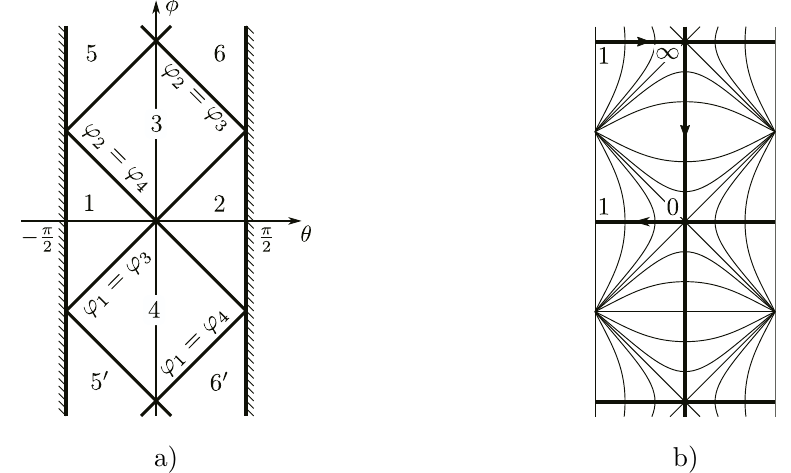
Figure 5 . a) Division of AdS 2 into regions bounded by light rays from the point x 0 = 0.